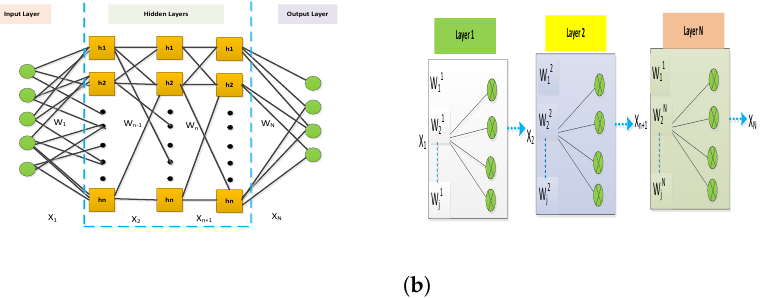
Figure 1. VCSEL-based ML model. ( a ). Fully connected deep neural network description (N layers), including input vectors; ( b ) representation of activation and matrix vector in each